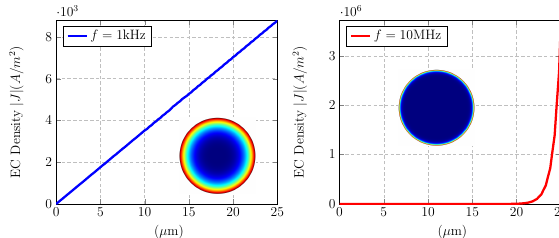
Figure 7: Distribution of electrical density of a circular from center to boundary. Material: Iron. Radius, R = 25 µ m , Magnetic induction: 10